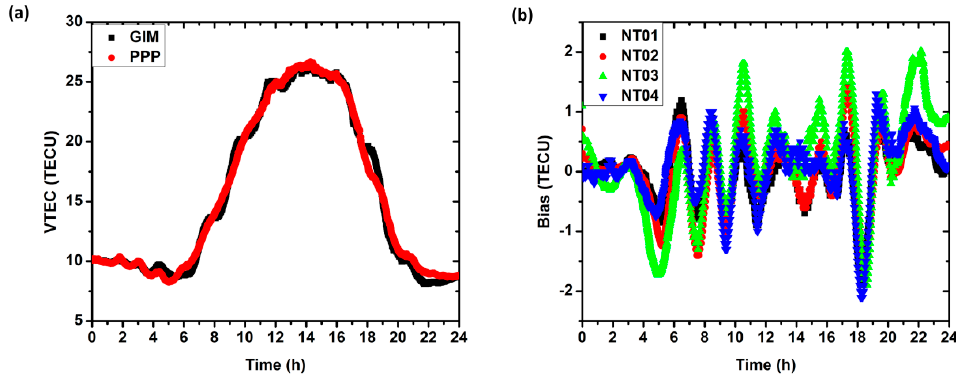
Figure 6. ( a ) The time series of VTEC at station “NT01” on day of 080 for the grid ionosphere model (black) and the PPP solution (red); ( b ) The differences of VTEC between the grid ionosphere model and the PPP solution for the four selected stations.